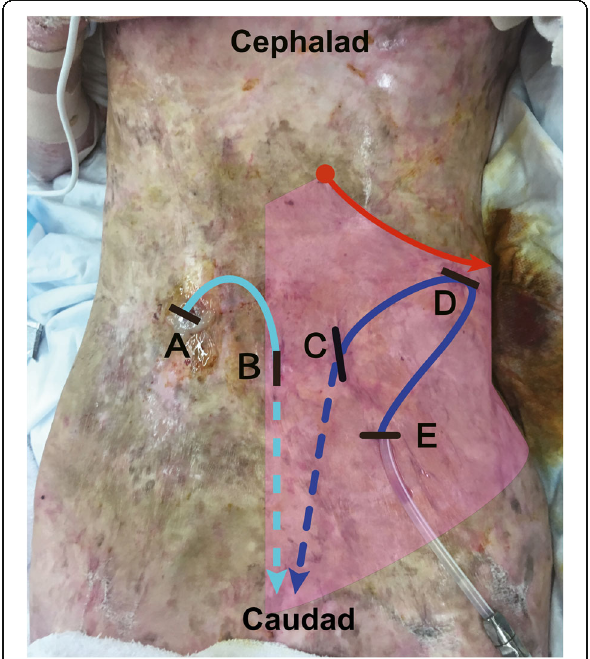
Fig. 1 Postoperative image of the surgery site. The incision points and course of removed (light blue arrow) and newly inserted (blue arrow) peritoneal dialysis catheters are shown. The subcutaneous traveling is indicated by solid lines, and the insertion into the peritoneum cavity is indicated by broken lines. The black lines represent incisions (A – E). The red dot and arrow along the subcostal oblique line indicate the injection point and course of local anesthesia via subcostal transversus abdominis plane block. The light-red coloration indicates the expected analgesic